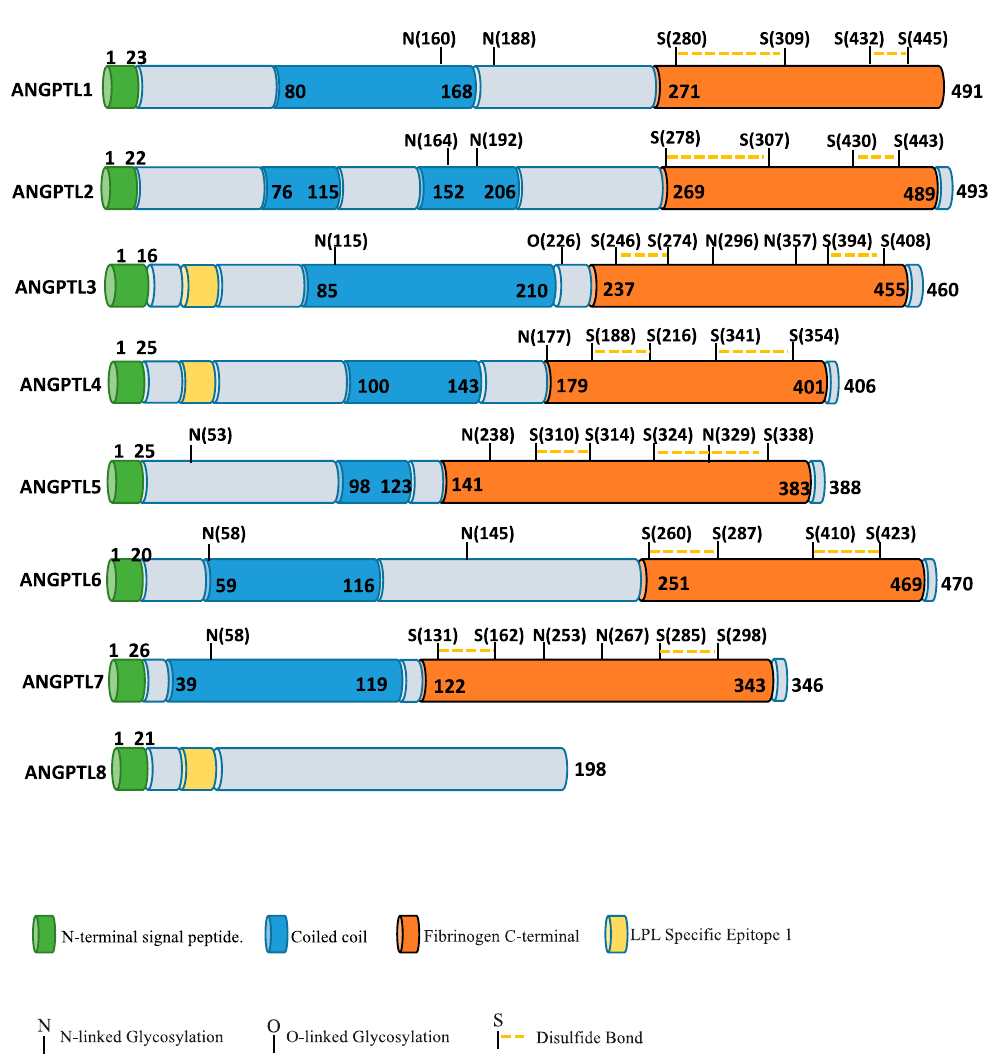
Figure 1. Schematic representation of ANGPTL proteins structure. The ANGPTL family has three conserved domains; a N-terminal signal peptide, a coiled coil domain and a fibrinogen like domain.